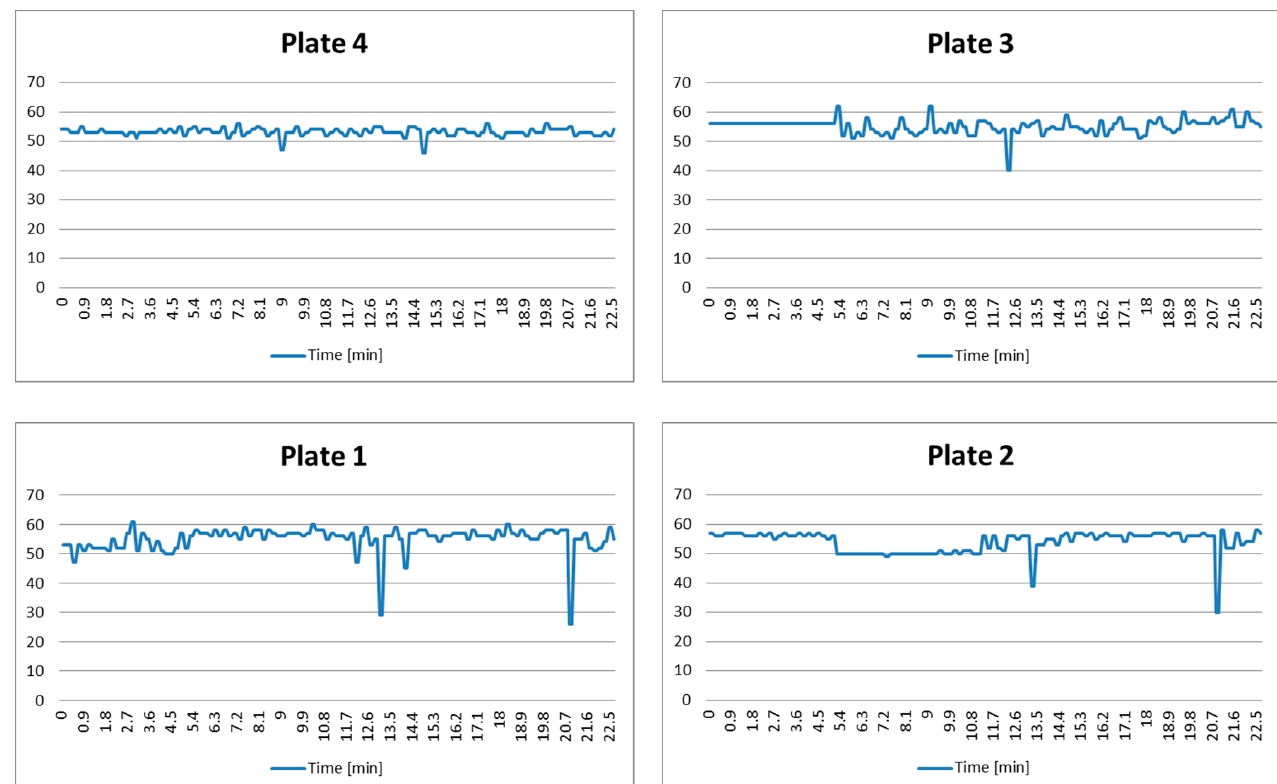
Figure 9. Measured distances for each plate during the typical cooking process. Table 8. Analysis of the results for typical cooking process.